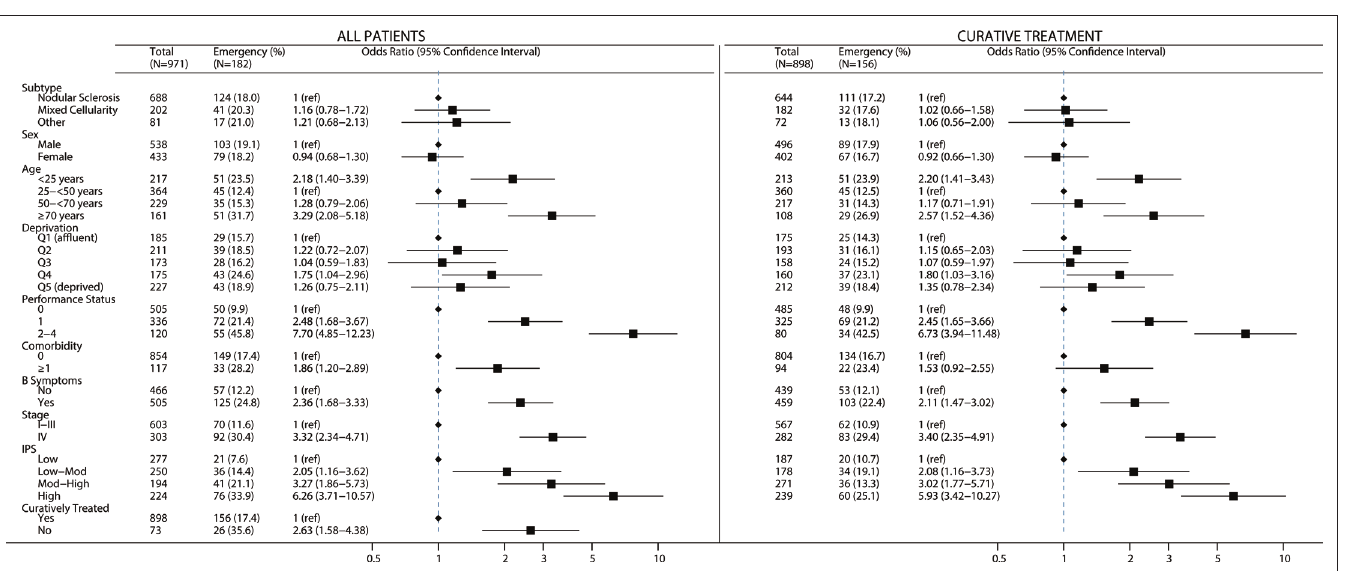
Lamb MJE et al . BJGP Open 2019; DOI: 10.3399/bjgpopen19X101668